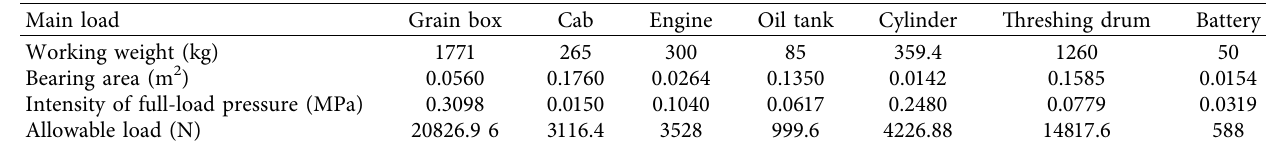
Figure 15: Integral assembly of crawler chassis. Table 5: Main component variable of the combine harvester.